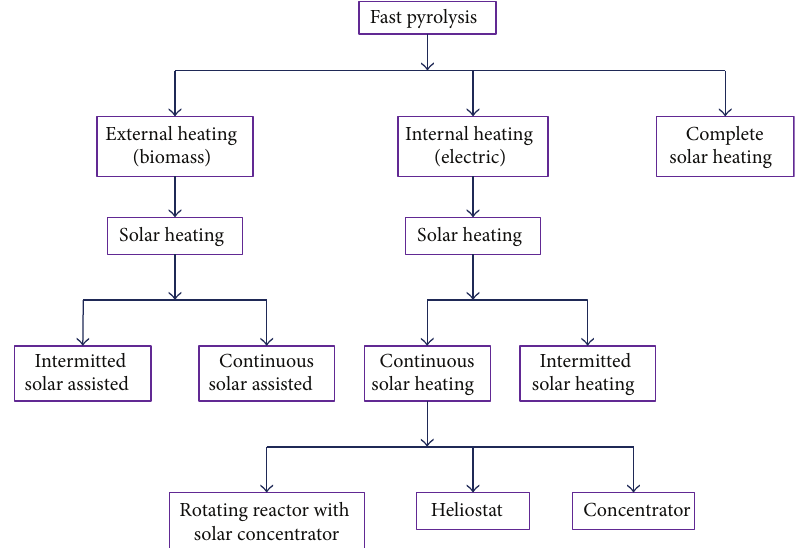
Figure 3: Classification of solar (assisted) fast pyrolysis.